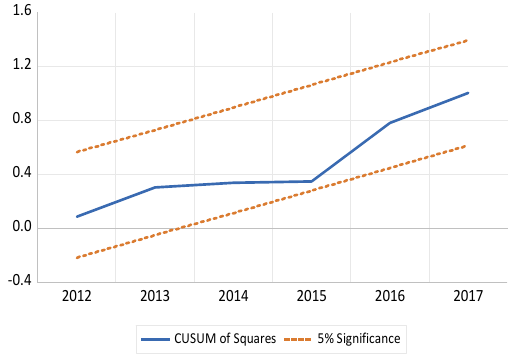
Figure 4. CUSUM test for the nonlinear ARDL model.